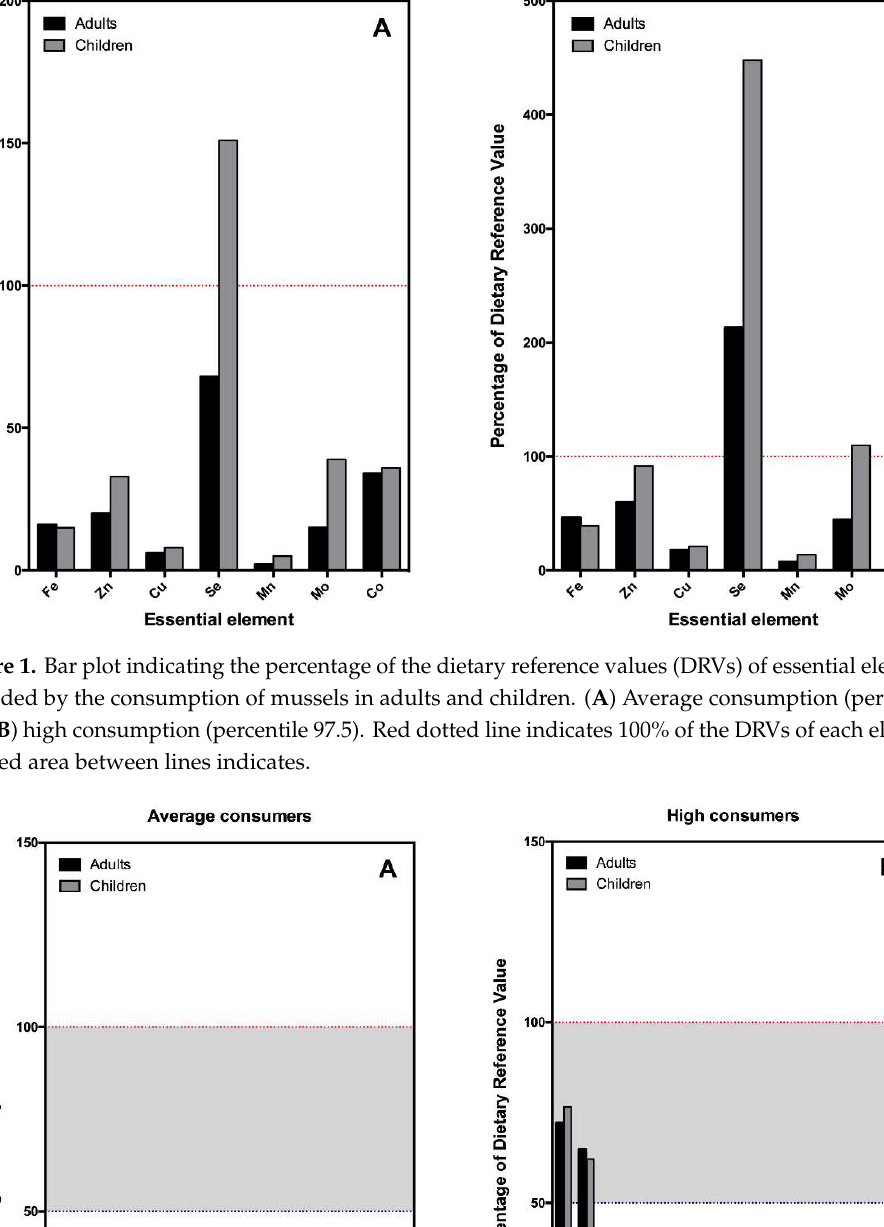
Figure 2. Bar plot indicating the percentage of the TDI of toxic elements provided by the consumption of mussels in adults and children. ( A ) Average consumption (percentile 50); ( B ) high consumption (percentile 97.5). Red dotted line indicates 100% of the TDI of each element.